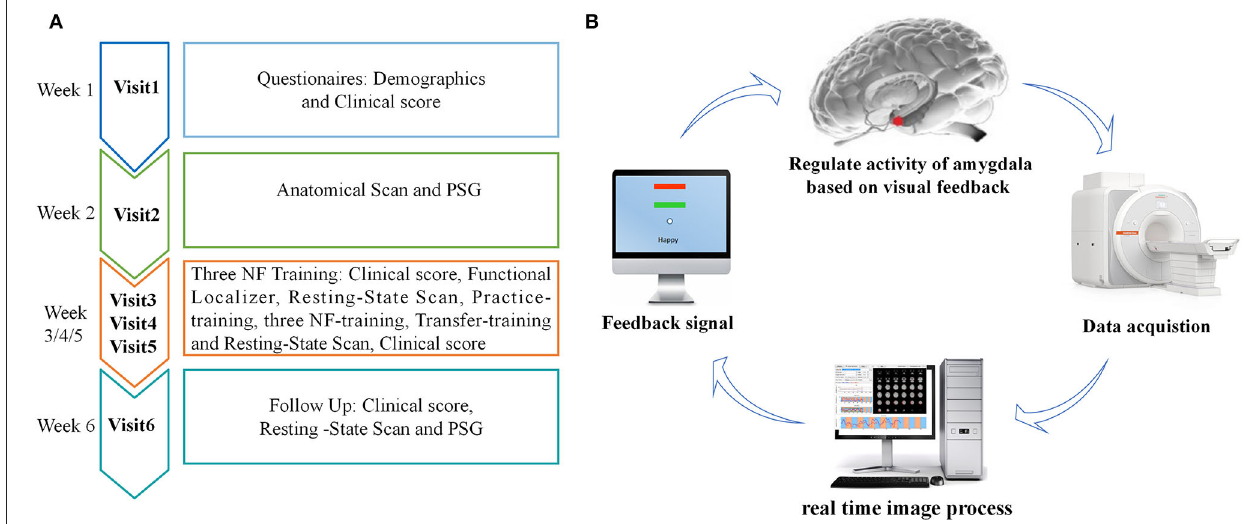
FIGURE 1 | (A) Procedure of rtfMRI-NF training experiment. The experimental protocol consisted of six visits, lasting for ∼ 6 weeks. During the third, fourth, and fifth visits, each rtfMRI-NF training session included eight runs, lasting for ∼ 50min. (B) Schematic of amygdala-based rtfMRI-NF loop for patients with CID. Typically, brain images were acquired using the MR scanner online and analyzed using the OpenNFT software in real time. Then, the signal of amygdala activity was provided as feedback to patients with CID for neural self-regulation. rtfMRI-NF, real-time fMRI neurofeedback; PSG, polysomnography; CID, chronic insomnia